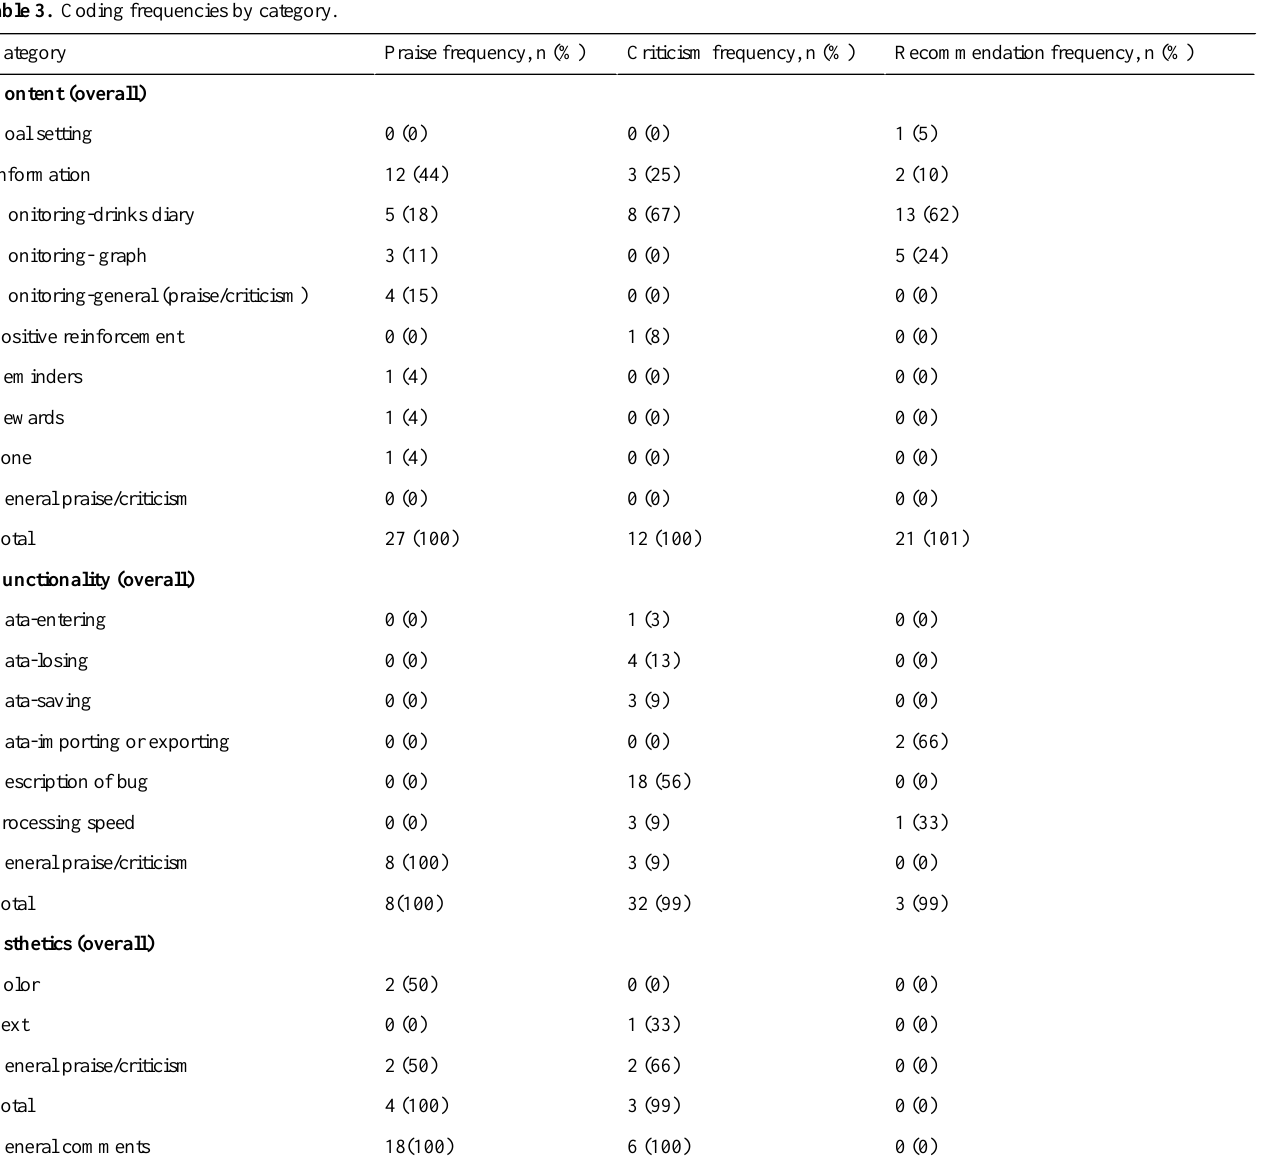
Table 3. Coding frequencies by